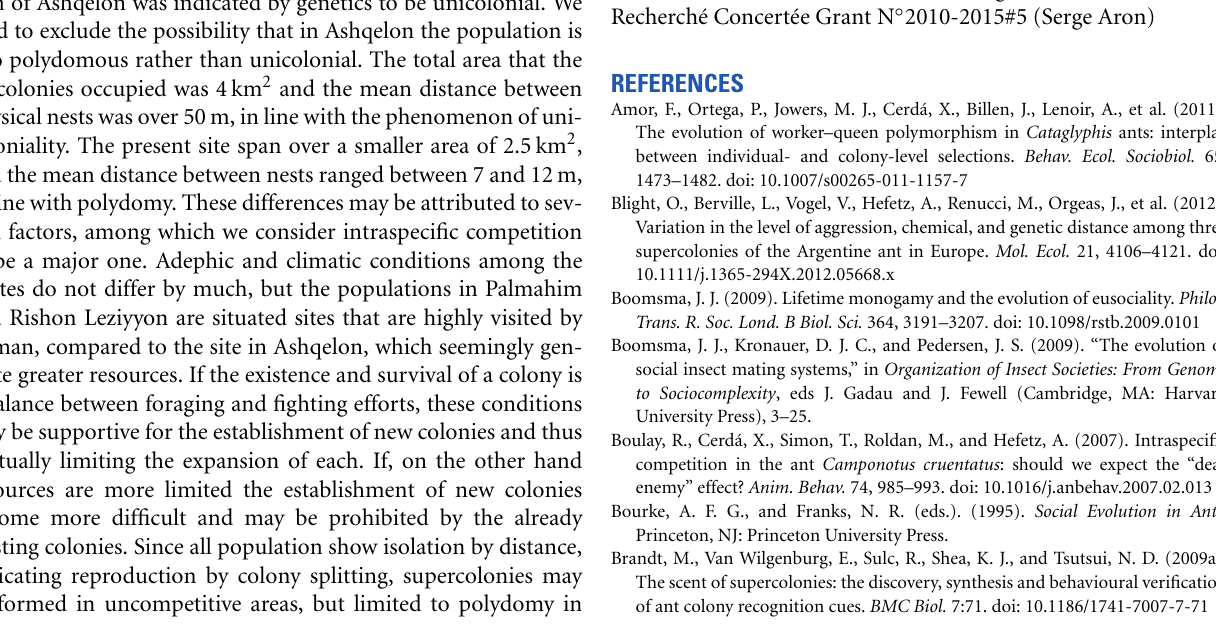
analyses (B) . R1–R4 denote the 4 colonies in Rishon Leziyyon population (colony 5 comprised only one nest and therefore excluded), and P1-P3 denote the 3 colonies of the Palmahim